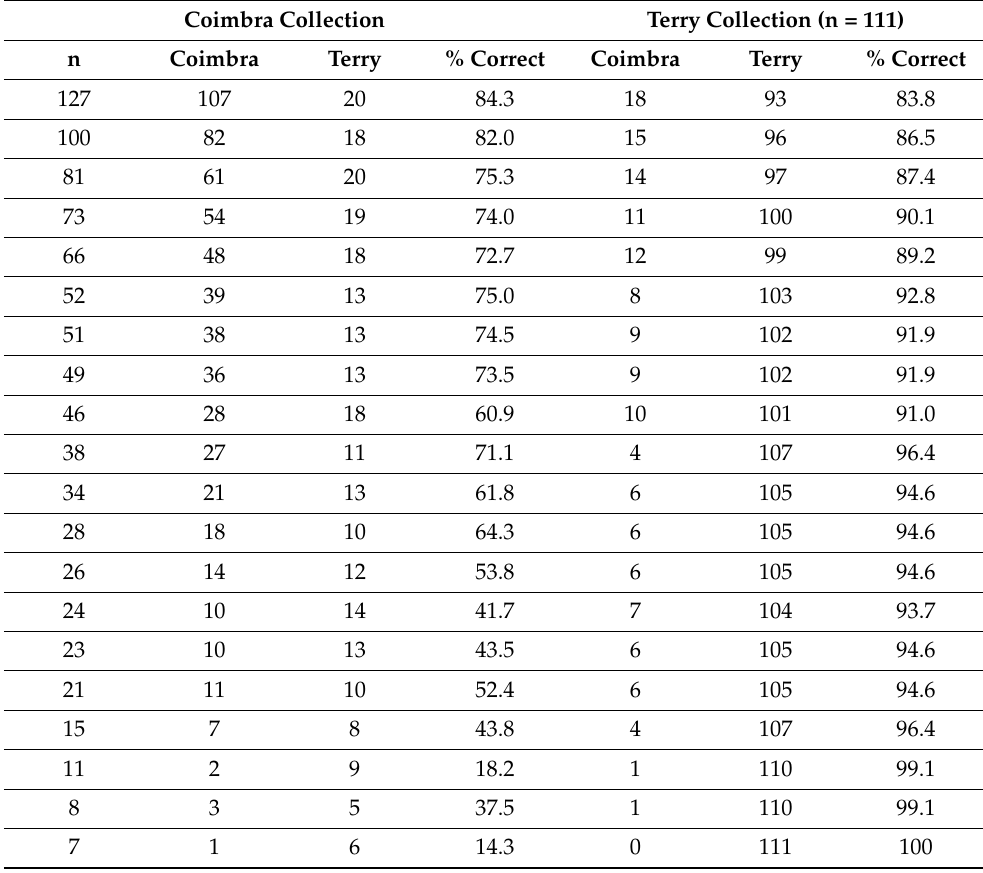
Table 2. Allocation accuracies using logistic regression with decreasing sample sizes from the Coimbra collection used to model mass grave scenarios with all sexes. Sample size from the Terry collection was held constant (n = 111) as a reference sample.